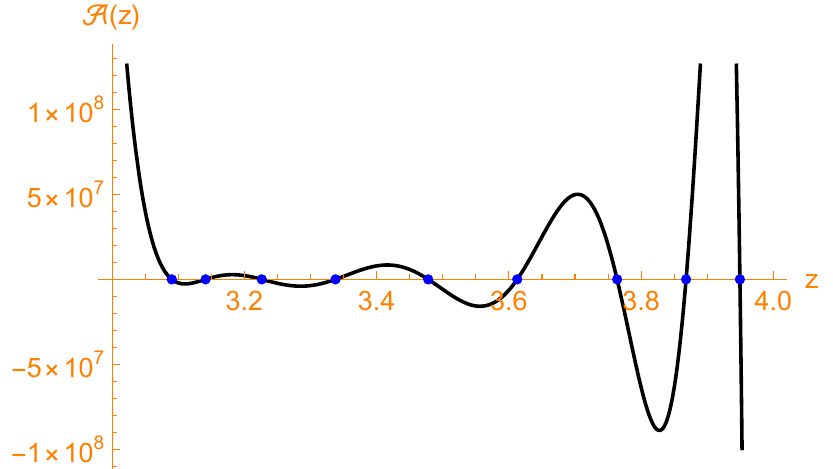
Figure 3 . Positive real roots of the polynomial equation A ( z ) = 0 with P = 0 . 0006737 , Q = 2 . 4544565 , α 2 = − 5 . 3439180 , α 3 = 72 . 4523175 , α 4 = − 1248 . 4241037 , α 5 = 23241 . 5416893 , α 6 = 431538 . 2300431 , α 7 = 7 . 4168150 × 10 6 , τ = 52 . 2102945